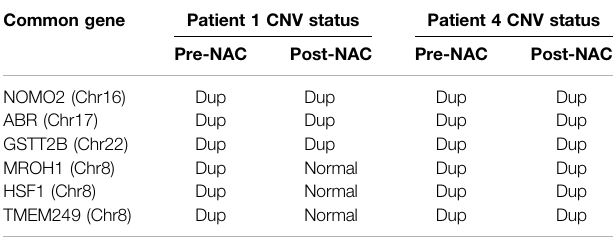
TABLE 3 | Common genes in pre- and post-neoadjuvant chemotherapy (NAC) as wellasits copynumber variation(CNV) status (inpre-andpost-NAC) forNAC- resistant patients that were detected by NextGENe software.